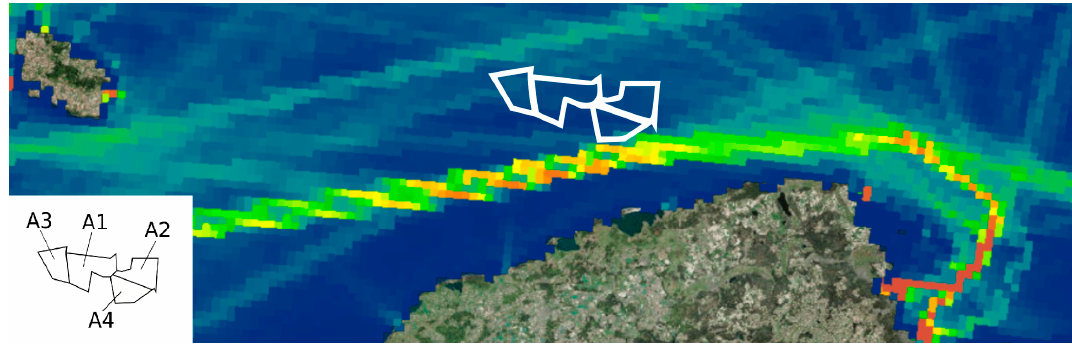
Figure 7. The decision variants in the context of shipping routes.